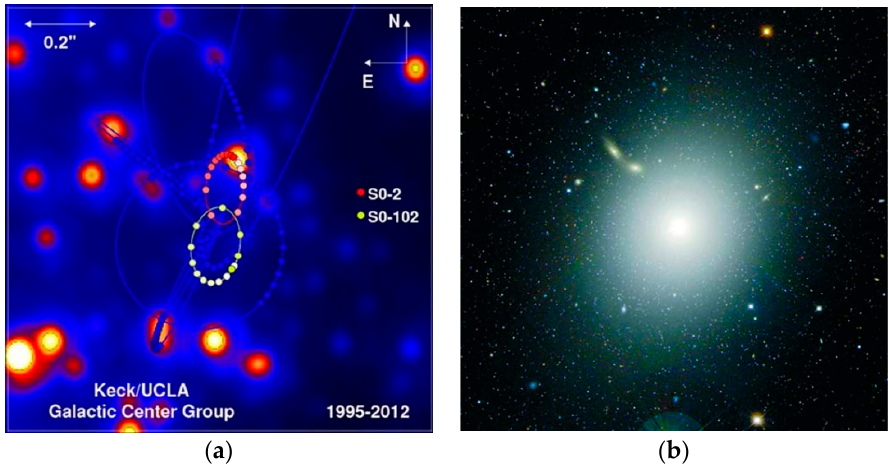
Figure 6. ( a ) The trajectories of several stars orbiting around the Galactic Center have been plotted from infrared observations continuously performed from 1995 to 2012 by the Keck telescopes in Hawaii. Their dynamical analysis implies the existence of a central massive black hole, Sgr A*, about 4 million solar masses; ( b ) The giant elliptical galaxy Messier 87, located in the Virgo local supercluster, shows a peak of luminosity at its very center, interpreted as the intense emission of gas falling into supermassive black hole about 6 billion solar masses.